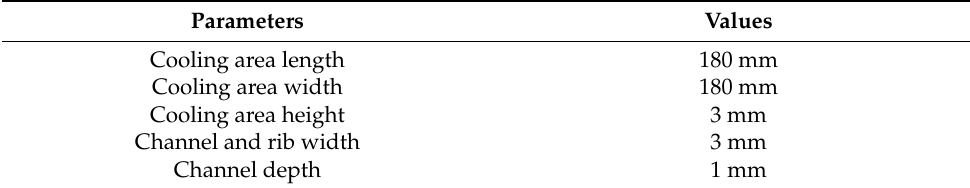
Figure 3. Design scheme of flow fields. Table 1. Model parameters of flow fields.